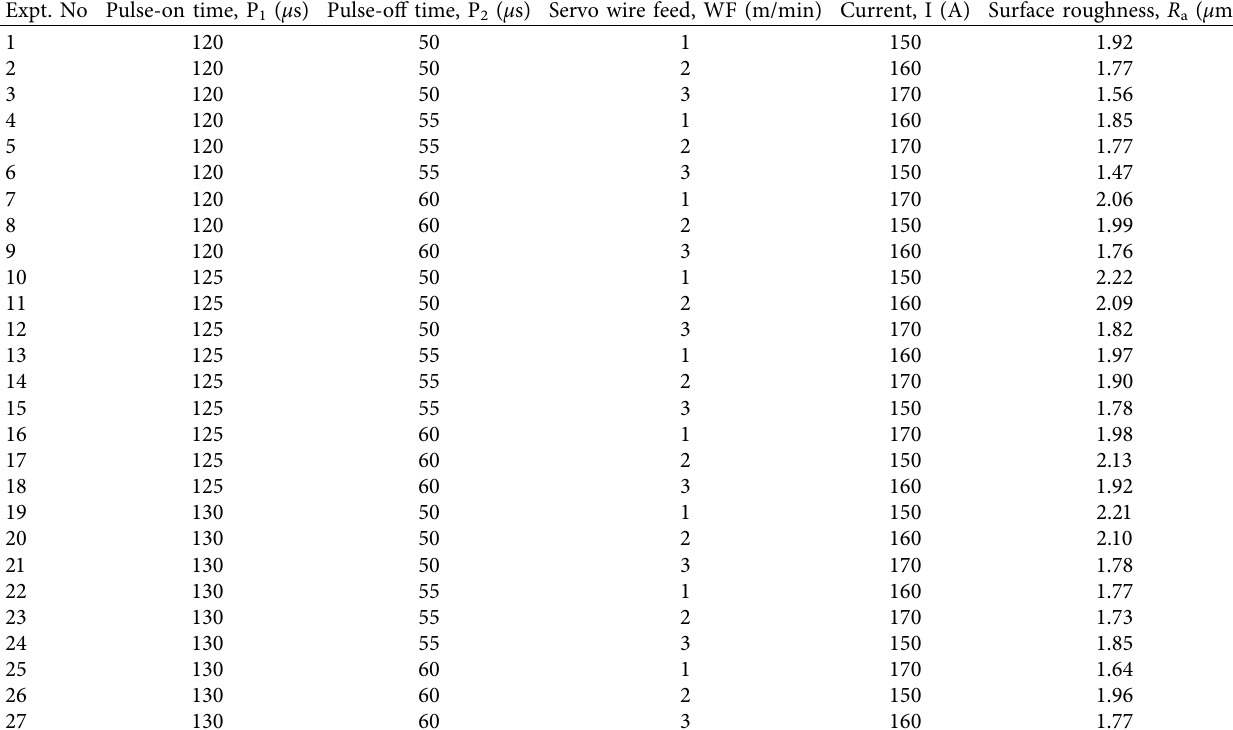
Figure 1: WEDM machining and machined sample. Table 5: Experimental